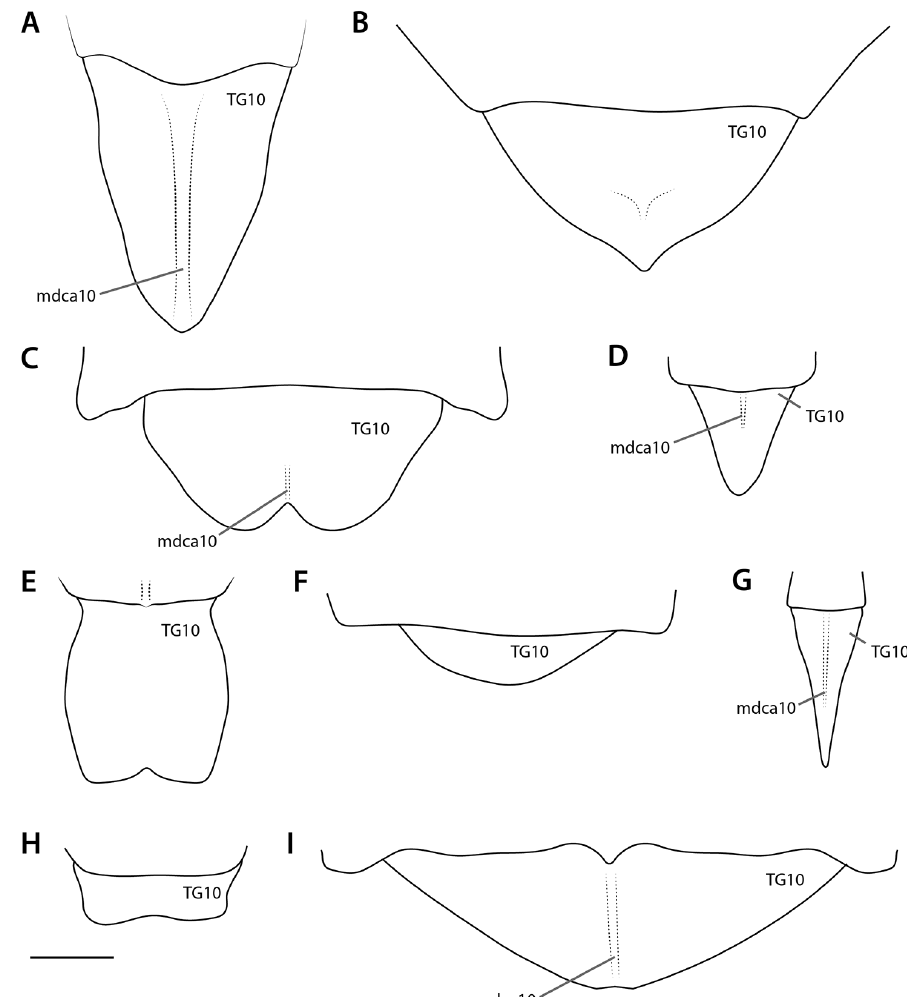
Figure 18. Morphological variation of supraanal plates. A Brunneria Saussure, 1869 ♀ B Coptopteryx Saussure, 1869 ♀ C Acanthops sp. ♀ D Callimantis Stål, 1877 ♂ E Fulcinia Stål, 1877 ♀ F Deroplatys Westwood, 1839 ♂ G Kongobatha diademata Heard, 1920 ♂ juvenile H Metallyticus splendidus ♀ (repro- duced and adapted from Wieland (2013)) I Deroplatys sp. ♀ . Abbreviations: mdca10 = middorsal carina 10; TG10 = tergite 10 (= supraanal plate). Scale bar: 1